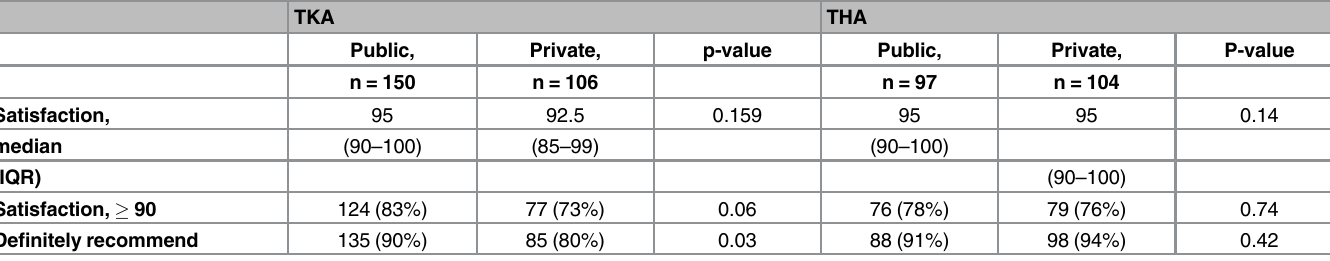
Table 3. Unadjusted outcomes: overall satisfaction and future recommendations for